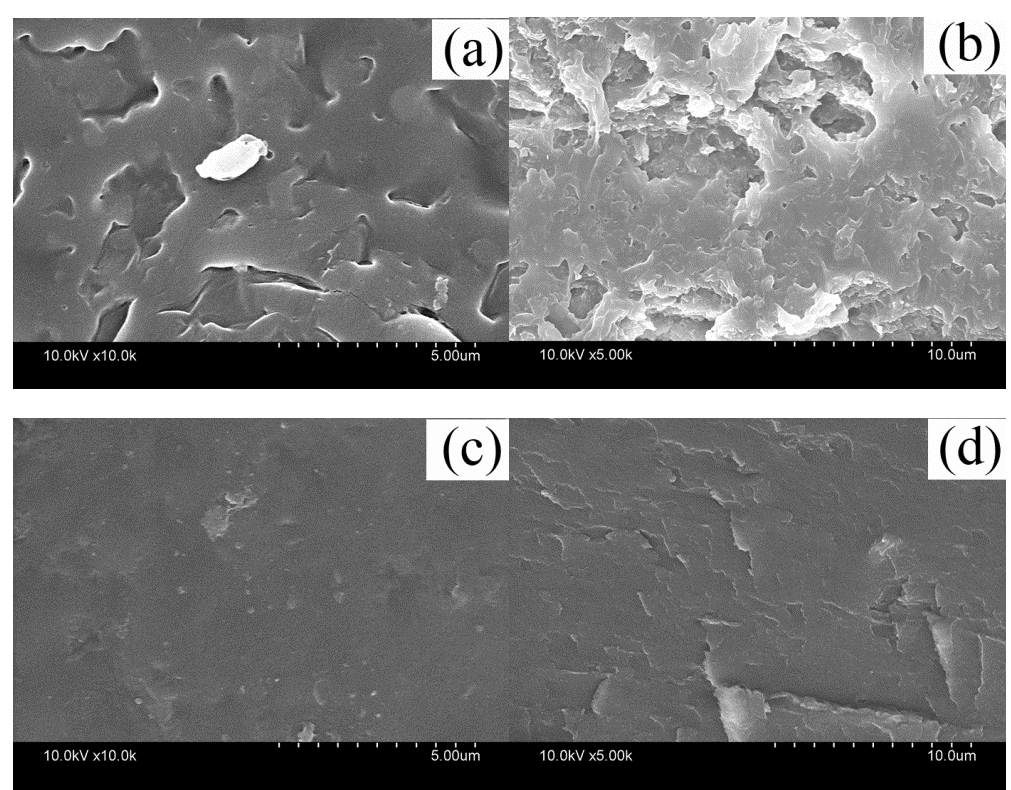
Figure 2. Scanning electron microscope images of ( a ) KF’s surface; ( b ) KF’s cross section; ( c ) GKF’s surface; ( d ) GKF’s cross section.